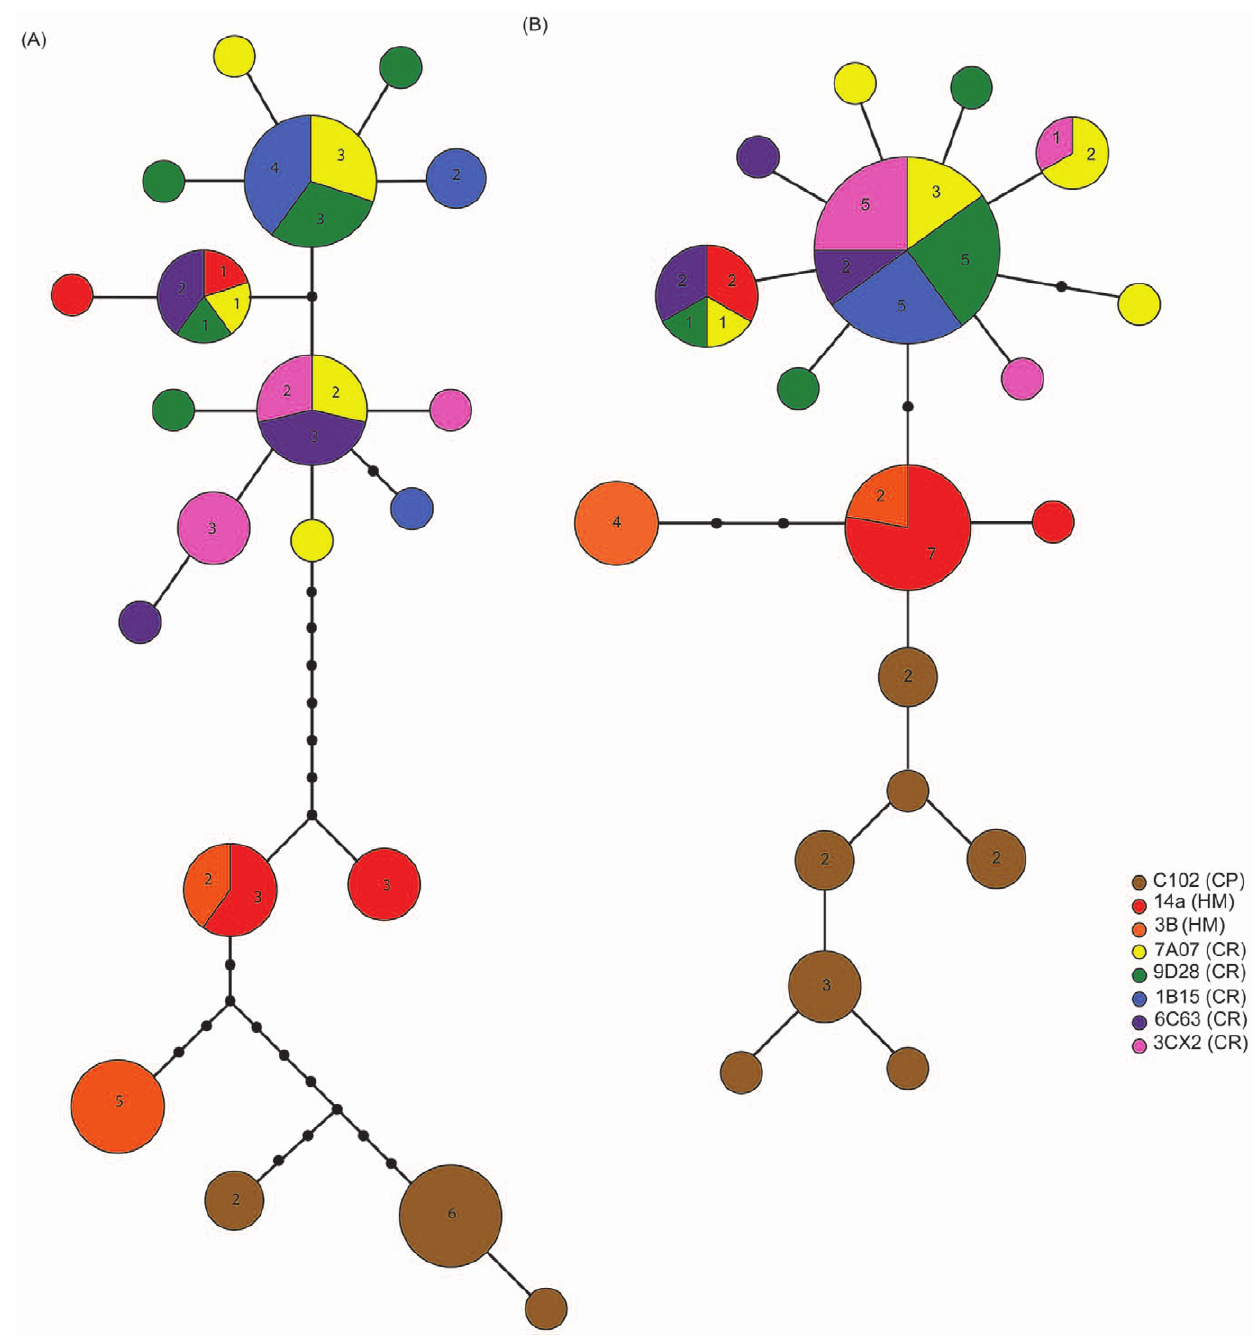
Figure 6. TCS haplotype networks for Hyalinoecialongibranchiata . Part (A) shows results for COI sequences and part (B) shows results for 16S sequences. Each circle represents an observed haplotype and the circles are proportional to the number of individuals sampled with that haplotype. Each color indicates a sampling site and when a haplotype was present at multiple sites, a pie chart indicates the proportions with absolute numbers appearing in text in the pie chart. Each line connecting colored circles represents a single nucleotide sequence change. Lines with small black circles indicate interior haplotypes not found in the dataset (multiple nucleotide changes between sampled haplotypes).